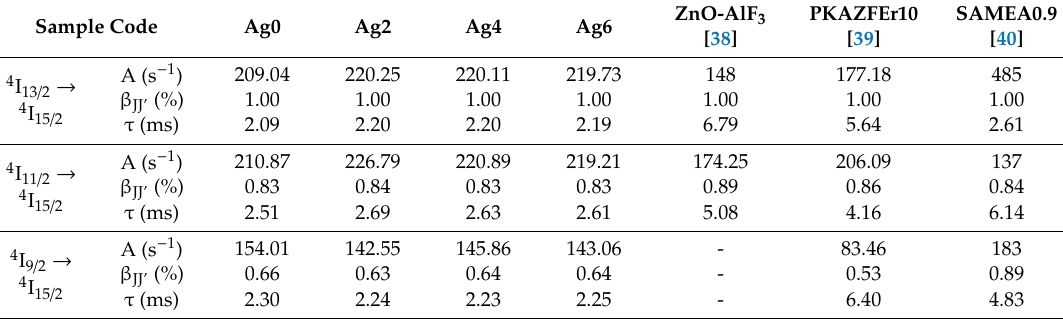
Table 4. Calculated radiative parameters of Ag / Er 3 + co-doped glasses. Sample